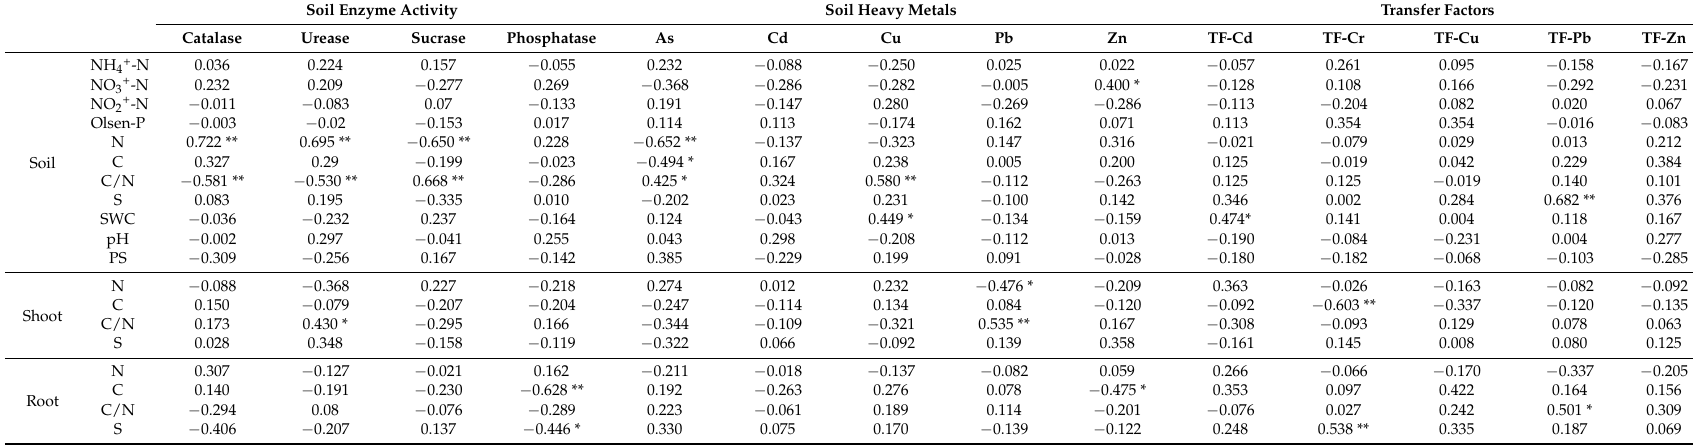
Table 3. The Pearson correlations between chemical properties of soil, root and shoot, soil enzyme, heavy metals and transfer factors in the copper tailings